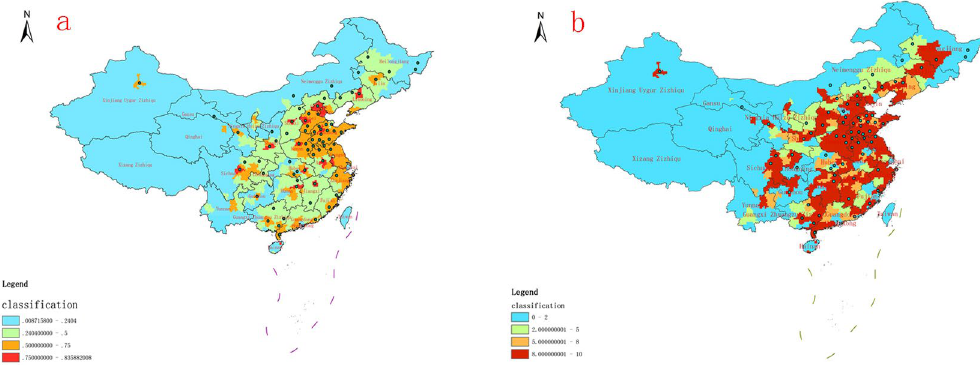
Figure 2. Spatial suitability distribution map of risk areas in China affected by vaccines involved. ( a ) The result of Maxent, ( b ) the result of GARP (Maps created in ArcGIS 10.2 (Environmental Systems Resource Institute,